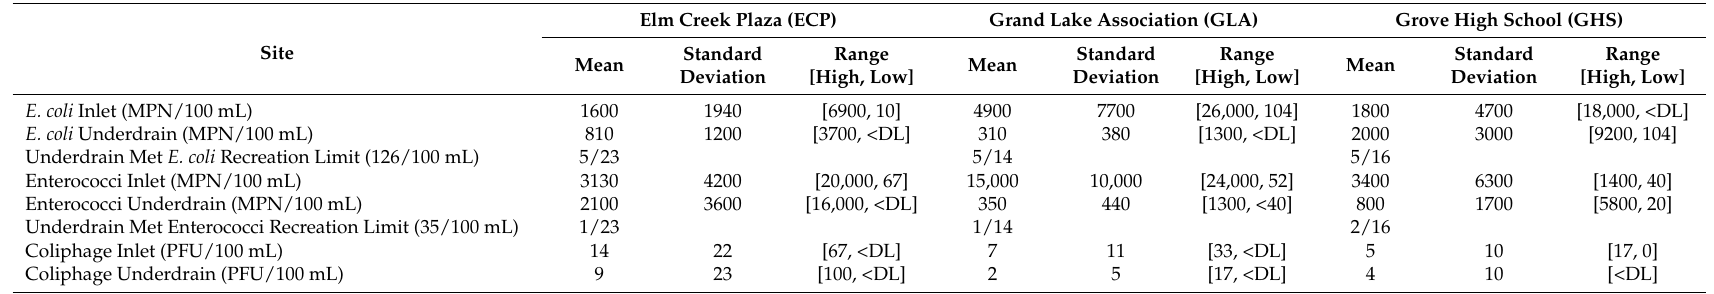
Table 5. Statistics of inlet and underdrain microbial concentrations from sampled storm events from May 2014 to October 2015 for the three monitored bioretention cells in Grove,